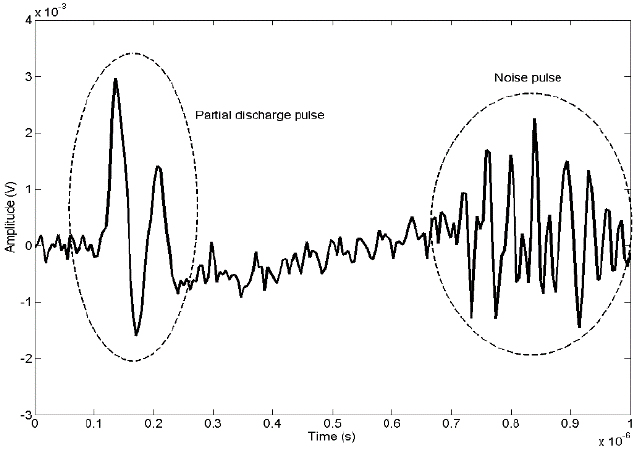
Figure 2. Example of a partial discharge plus noise.